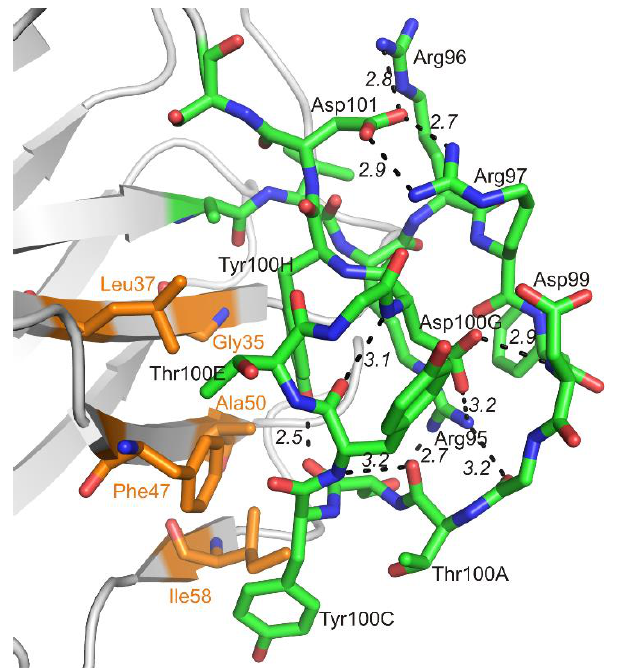
Figure 6. Interaction within the CDR-H3 loop (green) and its contacts with amino acid residues of the V H H domain as part of the Fab fragment (orange).